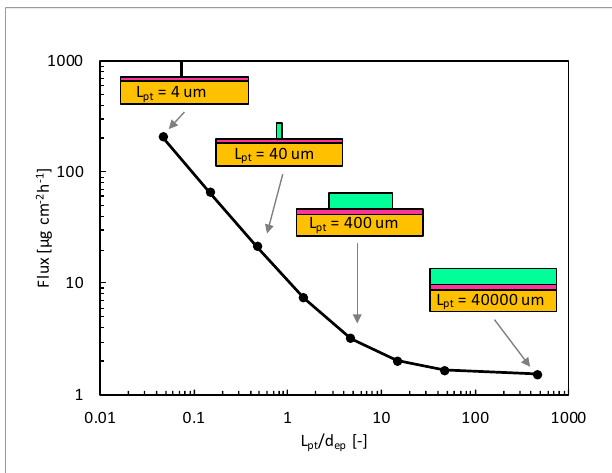
FIGURE 14 | Flux released by the patch into epidermis after 72 h (g pt,rel ) for the in fi nite reservoir as a function of the reservoir size (L pt ), so contact surface area, scaled by the epidermal thickness (d ep ). In the schematics, dimensions of the patch and skin thickness are to scale, but the skin width is not to